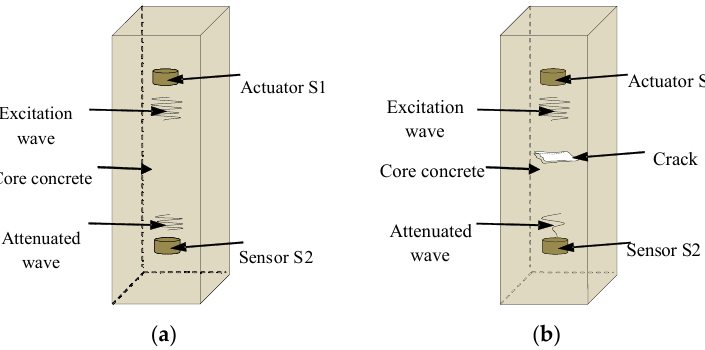
Figure 3. Active sensing approach to damage detection of core concrete using smart aggregates. ( a ) Core concrete in a healthy state; ( b ) Core concrete with a crack.